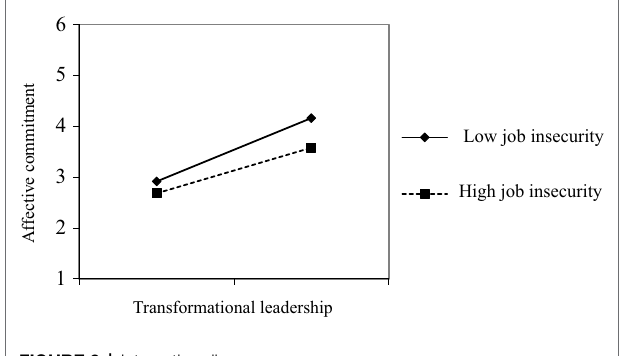
FIGURE 2 | Interaction diagram.